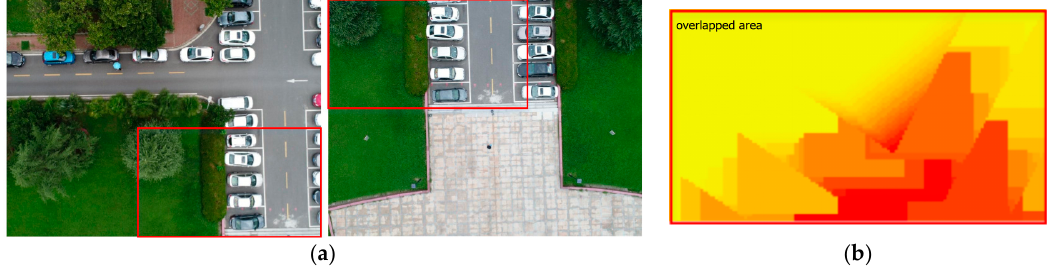
Figure 1 . An UAV image pair and their optical flow field rendering. ( a ) UAV image pair. ( b ) Rendering of optical flow field.